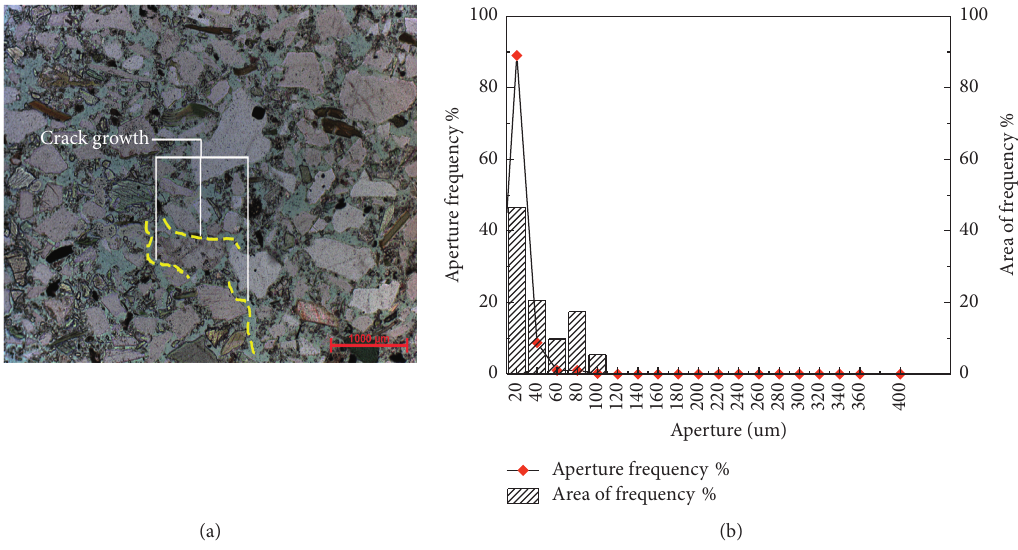
Figure 7: Elastic deformation stage of the cast thin section. (a) Slice image. (b) Pore statistical histogram.